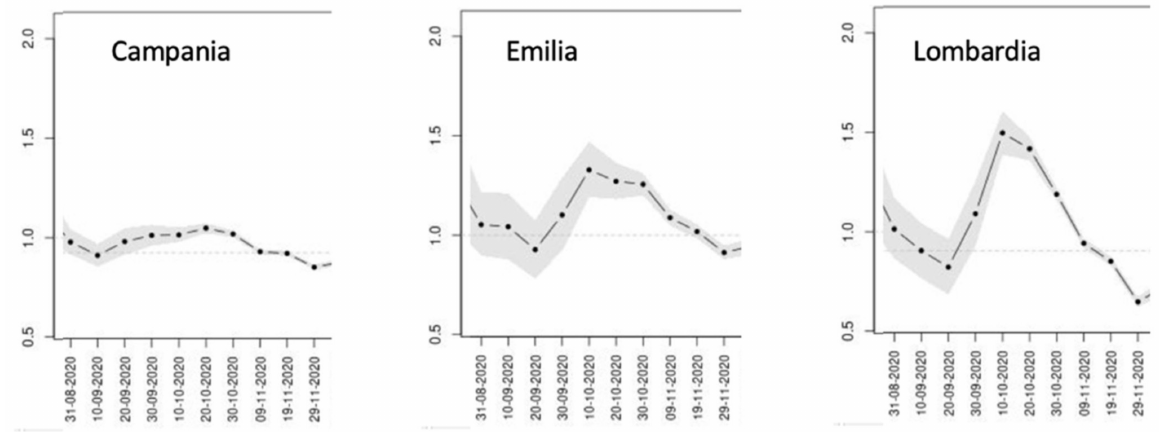
Figure 8. Rt trend for the three Italian regions: Campania, Emilia and